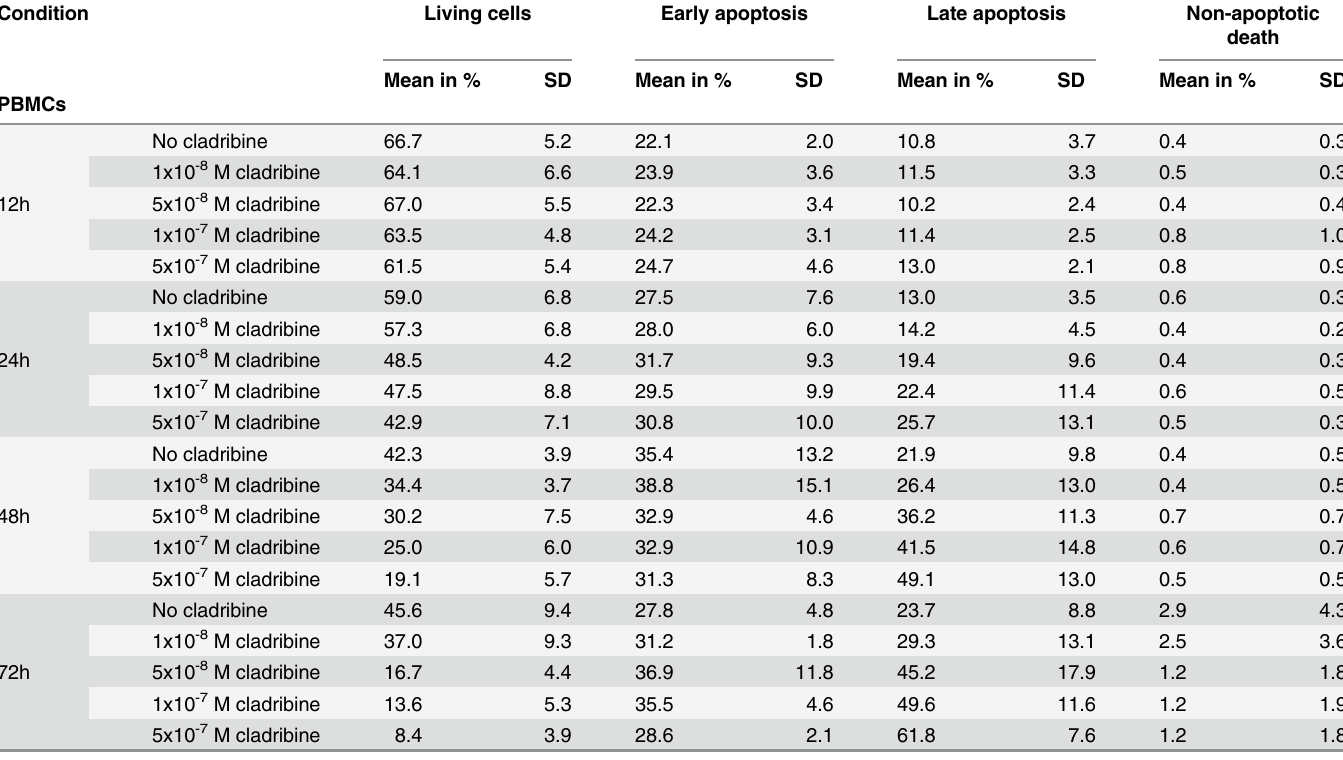
Table 1. Apoptosis of stimulated PBMCs caused by cladribine in vitro .